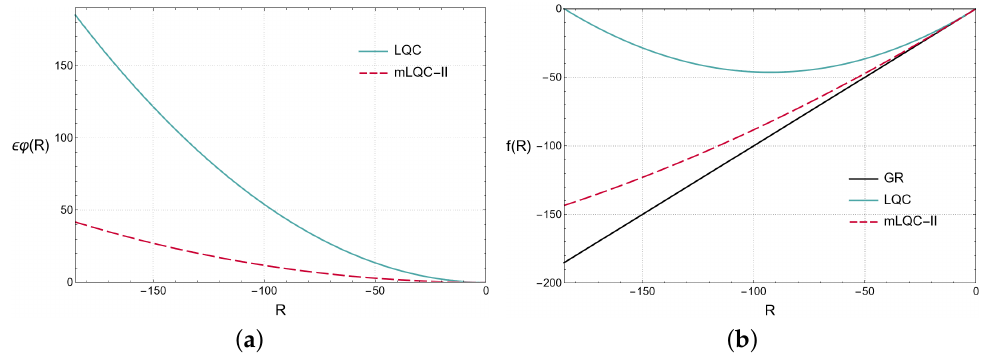
Figure 3. The plot ( a ) (Deviation, from GR, of the effective Lagrangian: a comparison between mLQC-II and LQC) presents the comparison between Equation (58), for the case of mLQC-II (dashed pink line), and Equation (35), for LQC (solid blue line), with c 1 = c 2 = 0, for − 18 κρ c ≤ R ≤ 0. Both of the corrections are dominated by the quadratic term. The plot ( b ) (Effective f ( R ) function: a comparison between mLQC-II, LQC, and GR) illustrates the differences between the Lagrangian density of GR (solid black line), with Λ = 0, and the effective Lagrangian densities, in the case of LQC (solid blue line), and Equation (60), for mLQC-II (dashed pink line), for the interval − 18 κρ c ≤ R ≤